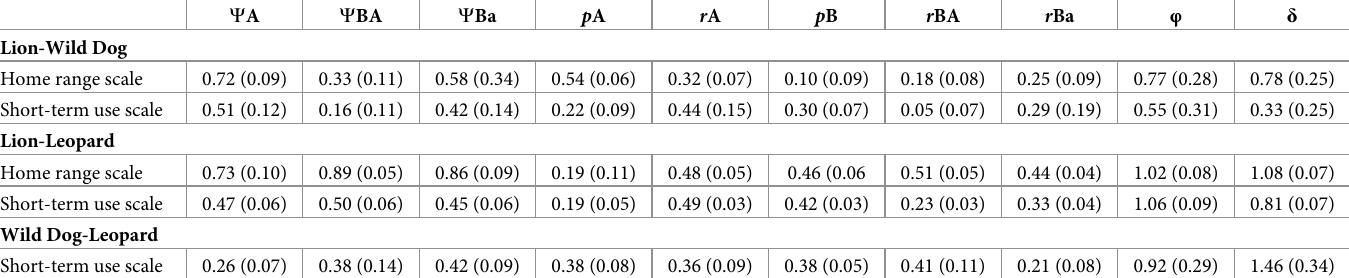
Table 2. Site use ( ψ ), detection probability (p and r), and species interaction factors (SIF–phi and delta) parameter estimates and associated standard errors from the top-ranked model investigating co-occurrence between lion, leopard, and wild dog in Ruaha-Rungwa, at the two spatial scales investigated. C A C BA C